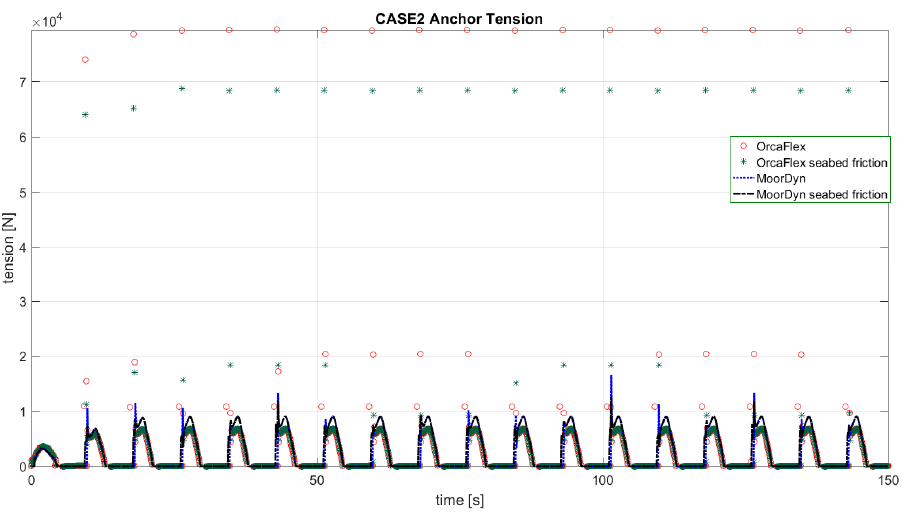
Figure 9. Simulation case 2: Anchor tension comparison.